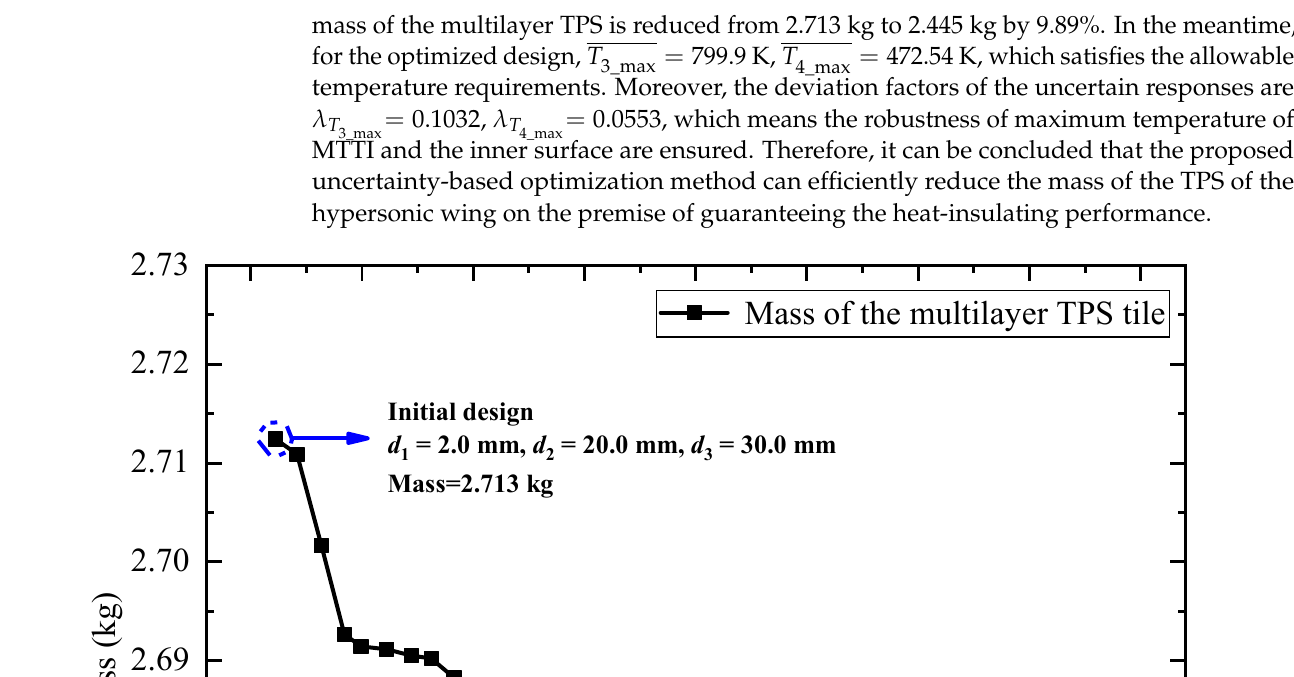
Figure 10. Setup of the thermal insulation performance test. ( a ) The thermal protection tile; ( b ) The experiment setup.